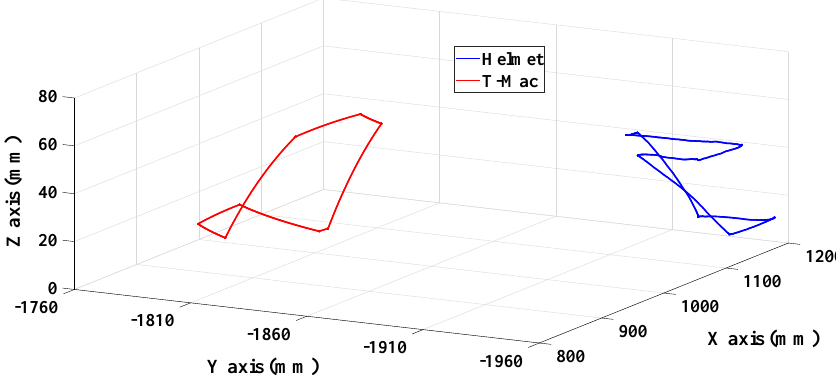
Figure 18. Motion trajectories of the helmet and the T-Mac in the laser tracker coordinate